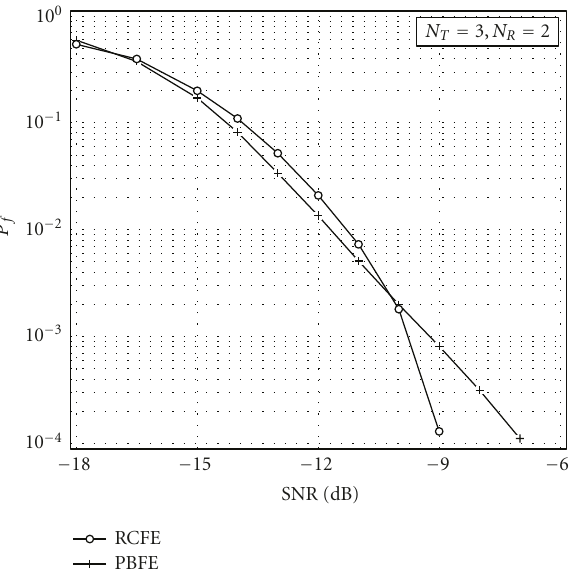
Figure 4: Probability of failure versus SNR for RCFE and PBFE with N T = 3 and N R =